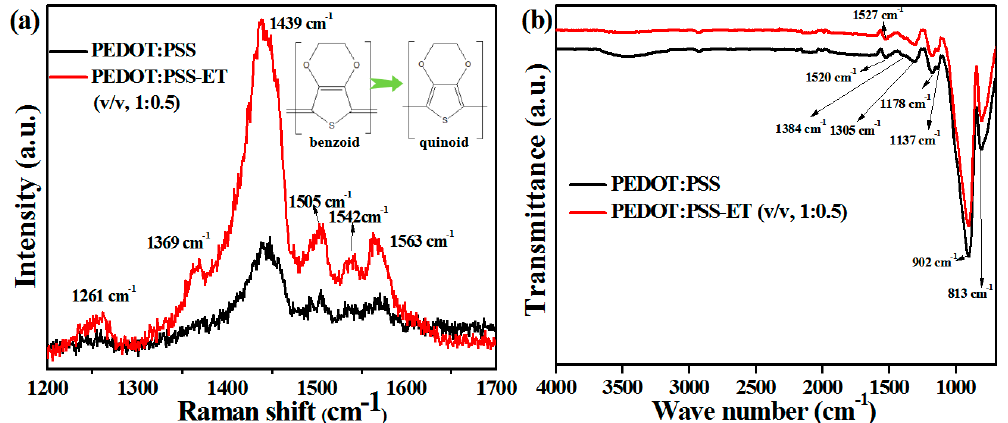
Figure 3. ( a ) Raman spectra of PEDOT:PSS and PEDOT:PSS-ET ( v / v , 1:0.5) films on glass with, and ( b ) FTIR spectra of PEDOT:PSS and PEDOT:PSS-ET ( v / v , 1:0.5) films.